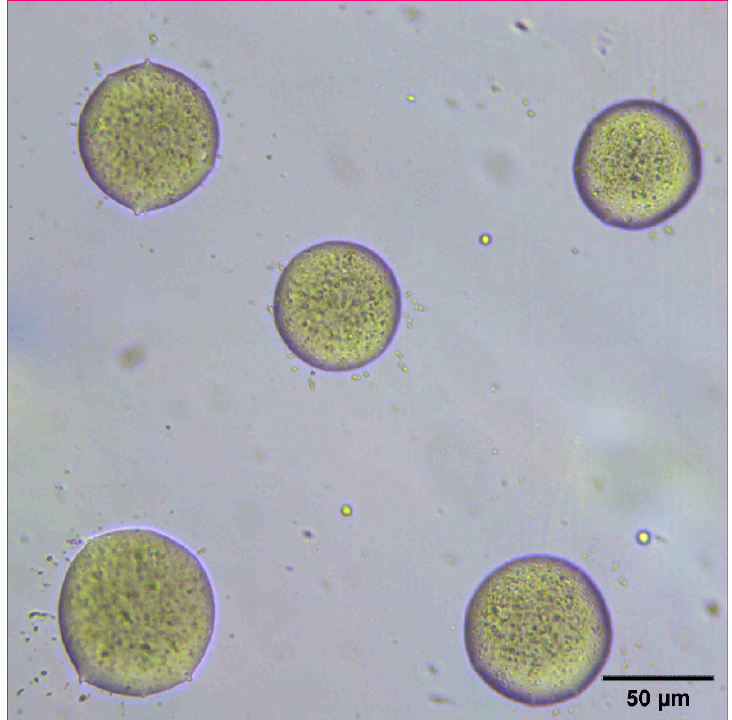
Figure 5. Optical microscope image of 10 mg/mL concentration naproxen nanosuspension after inkjet printing onto a film transparency at 500× magnification. Table 3. Deposition analysis of printed samples of naproxen nanosuspensions at 100 and 10 mg/mL